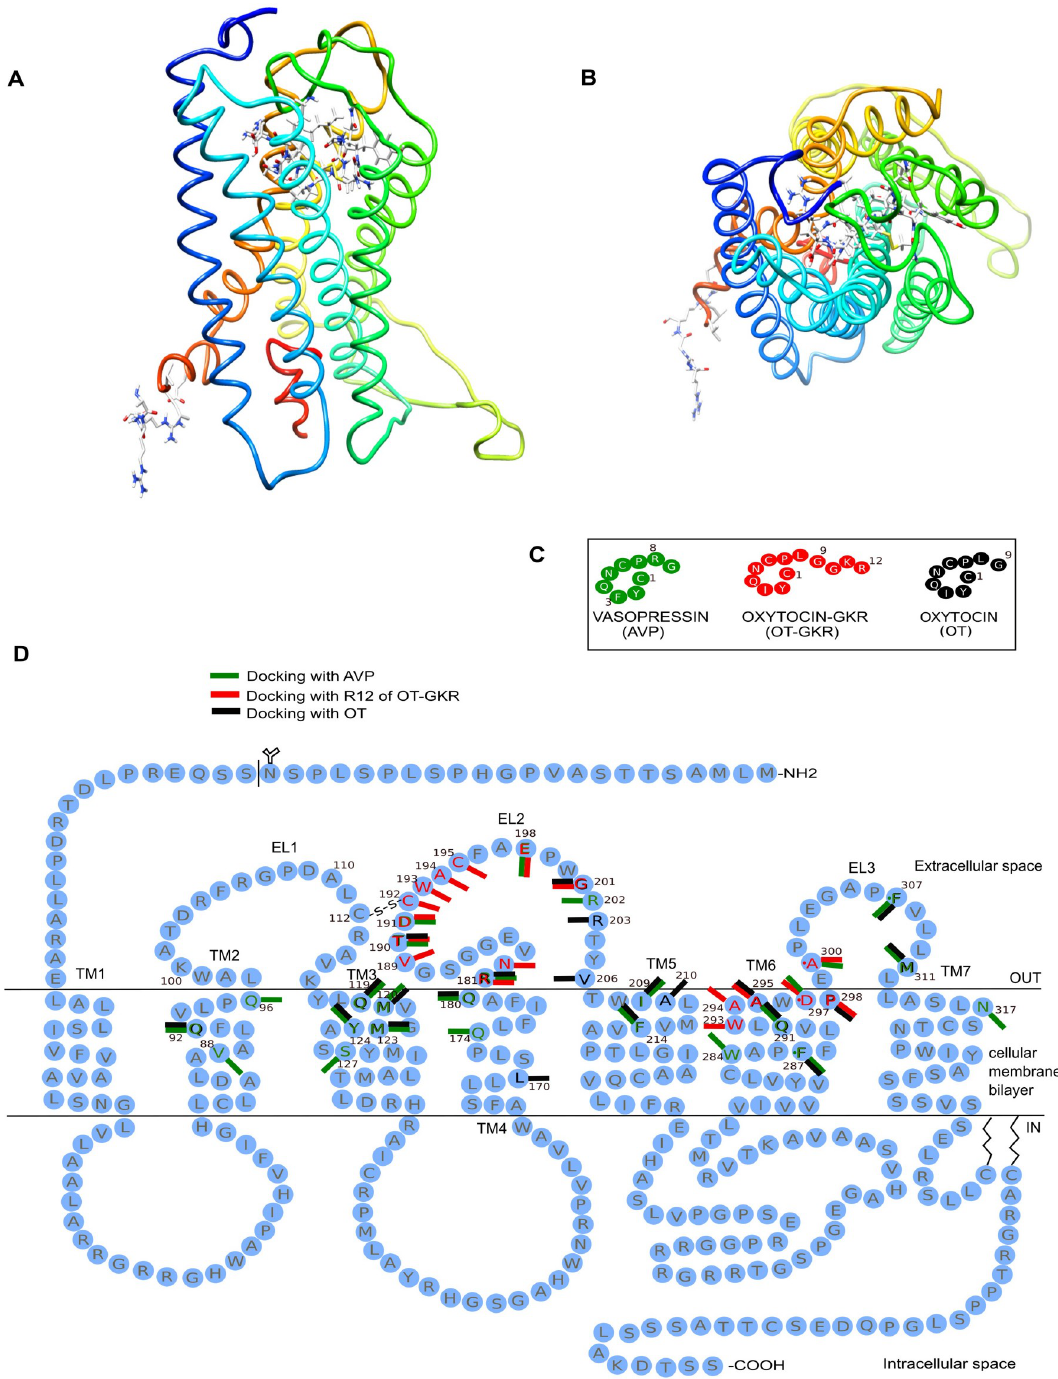
Fig 5. Schematic model of human vasopressin receptor (V 2 R) binding with oxytocin (OT), oxytocin extended form (OT-GKR), and arginine vasopressin (AVP). (A) The front upright view position (side view) of the receptor structure with OT. (B) The top intracellular view (i.e. rotation by 90 o out of plane) of OT-GKR inside the OTR binding site.(C) Conformational view of AVP, OT-GKR, and OT and (D) schematic model of human vasopressin V 2 R binding with AVP, OT-GKR and OT. The amino acid residues in black circles have been proposed as OT docking sites, the red bars represent docking sites of OT-GKR and the green bars represent docking sites of AVP. Amino acid residues are identified by a 1-letter code in Table 1.